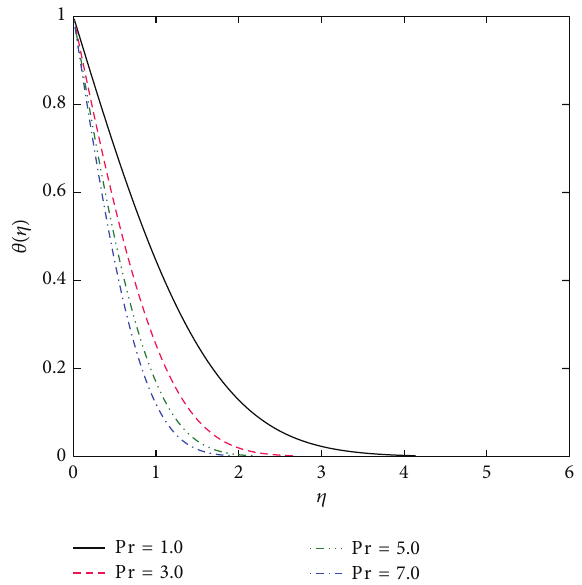
Figure 11: The effect of Pr on temperature profile when 𝑘 1 = 0.8 , = 0.5 , and 𝑚 = 0.5 . 𝜆 𝑇